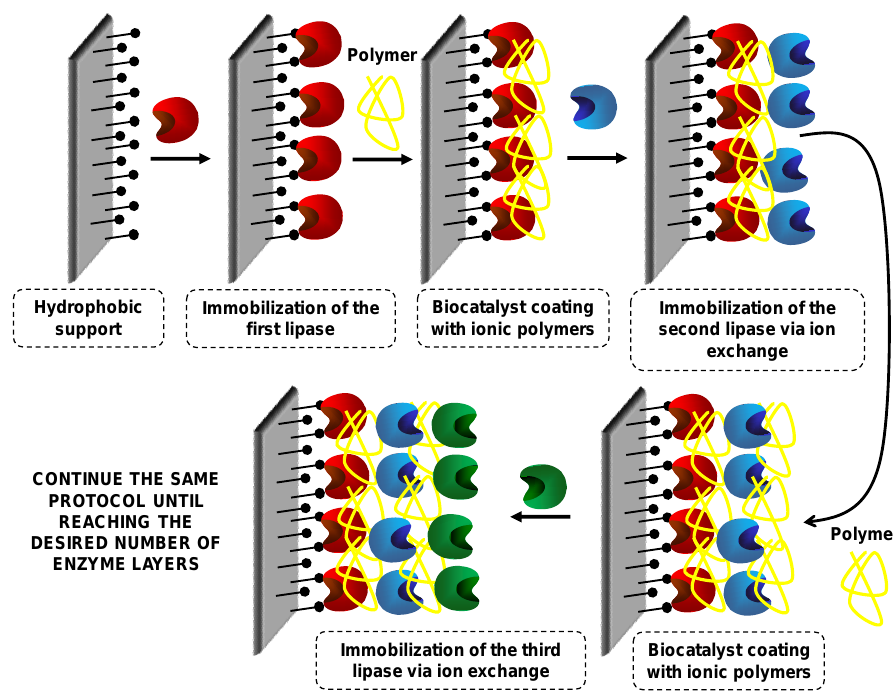
Figure 28. Coimmobilization of several enzymes with controlled spatial distribution using a multilayer strategy.